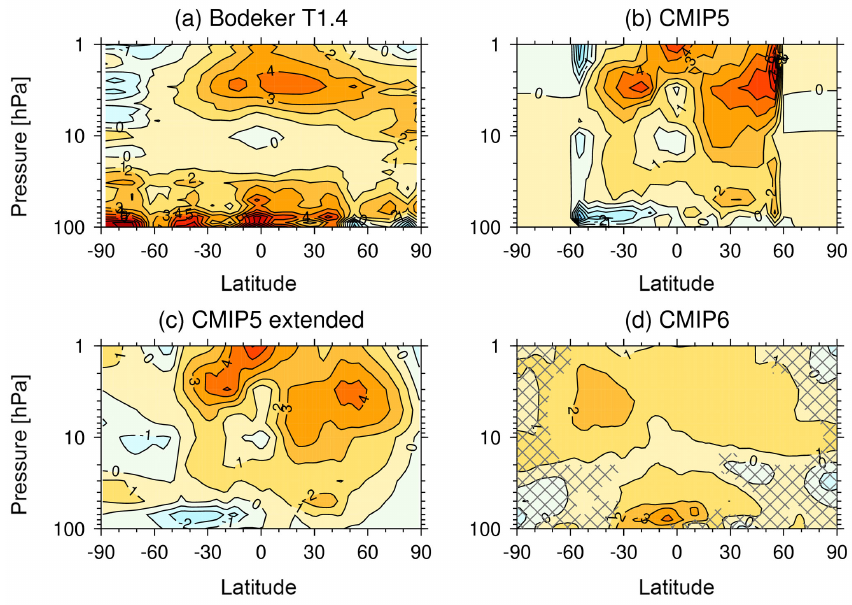
Figure 5. The annual mean percent (%) differences in ozone per 130SFU for the (a) Bodeker (1979–2007), (b) CMIP5 (1960–2005), (c) Extended CMIP5 (1960–2005) and (d) CMIP6 (1960–2011) ozone databases. The contour interval is 1%. The hatching in (d) is as in Fig. 3 (a–h)